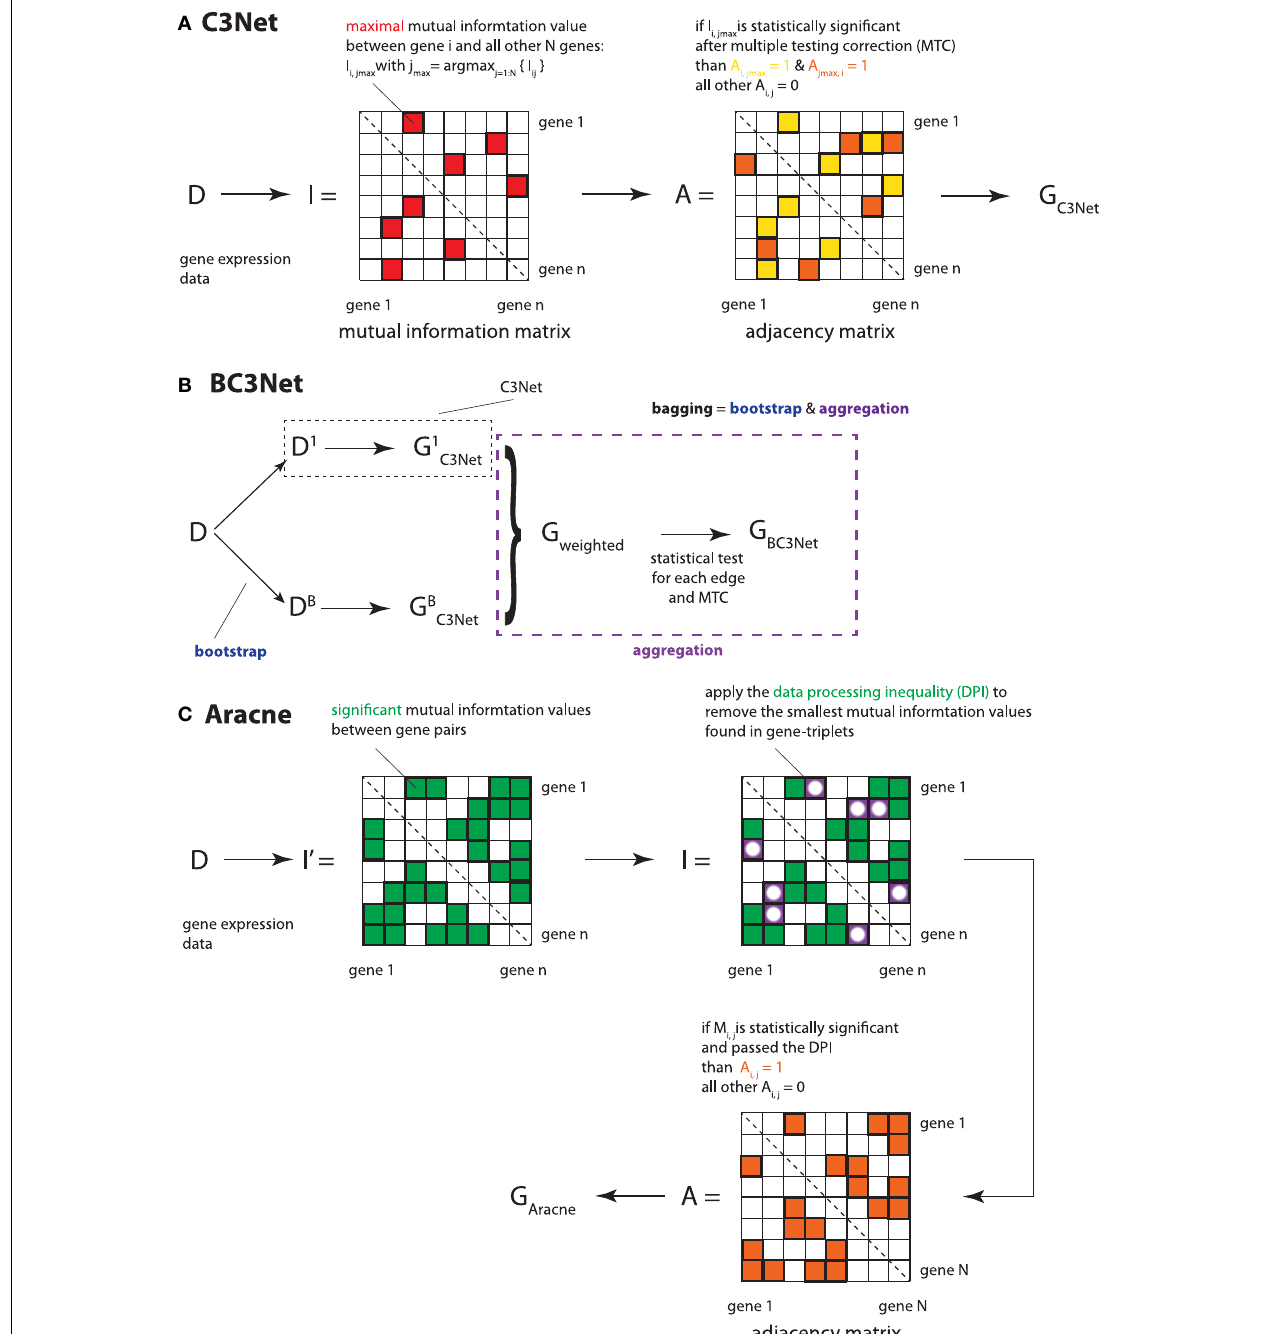
FIGURE 1 | Overview of the 3 applied inference methods and their key methodological analysis steps. (A) C3Net, (B) BC3Net and (C) Aracne.